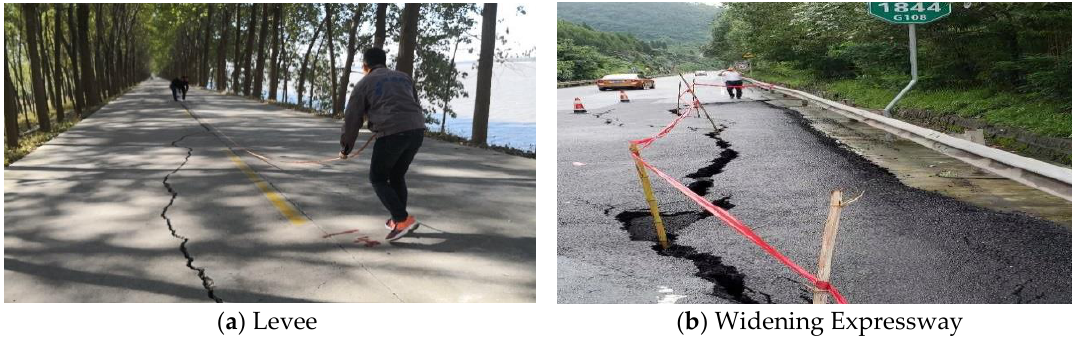
Figure 1. Pavement cracking.